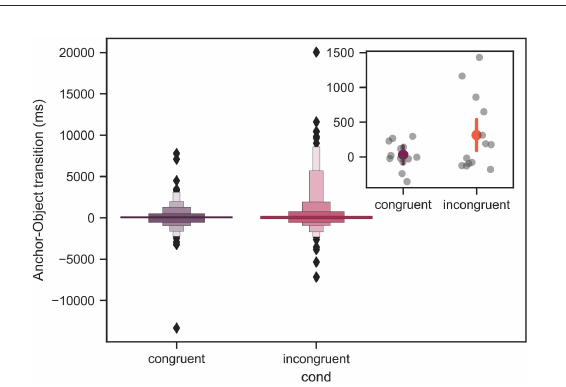
FIGURE12 Mean anchor-object transition across all trials for all measured participants represented by boxen plots. The black diamond markers correspond to the outliers. For more details on the boxen plot structure see main text. The inset in the upper right location demonstrates the mean values with the respective 95% confidence intervals computed using bootstrapping (see main text). The gray individual points in the inset plot correspond to the mean value for each individual subject. The axes labels of the inset plot are identical to those of the main plot. There was a significant difference between the congruent and incongruent conditions with p <